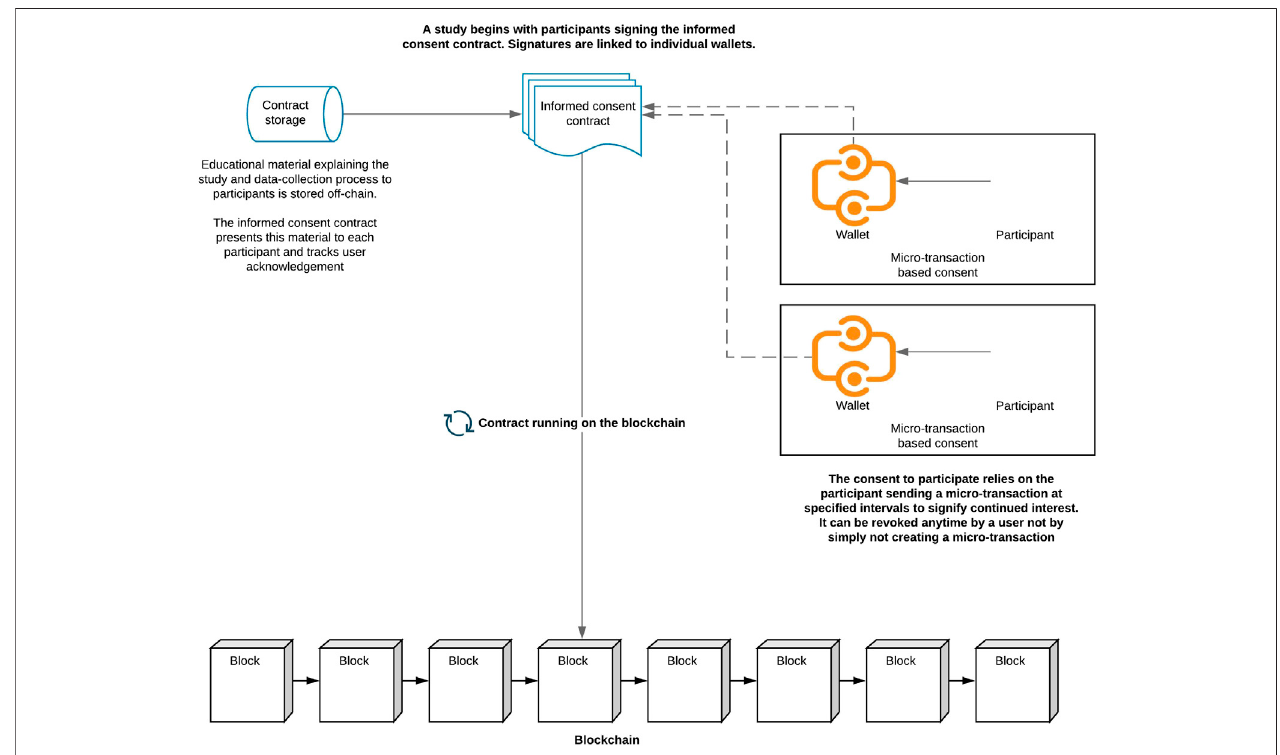
FIGURE 1 | Informed consent smart contract constantly updates on the blockchain. Each user consents to the contract via microtransactions that are sent periodically to maintain participation in the study. Revoking consent simply requires no further transaction from the user-wallet.